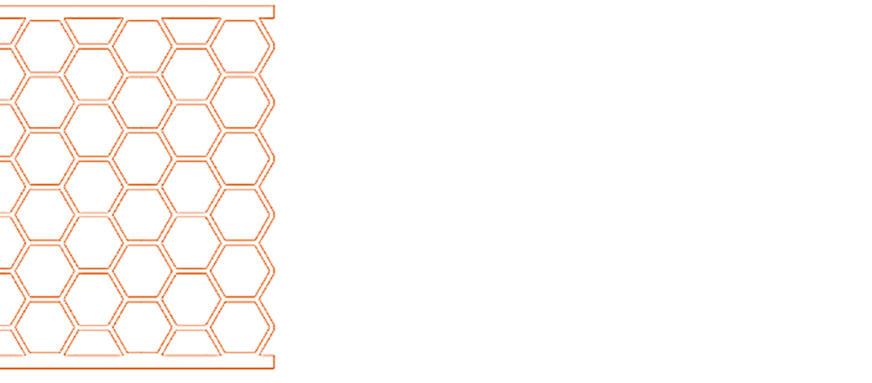
Figure 1. Generic hexagonal structures used to develop hierarchical models. Both the hexagonal array and the top and bottom load transfer plates are shown.